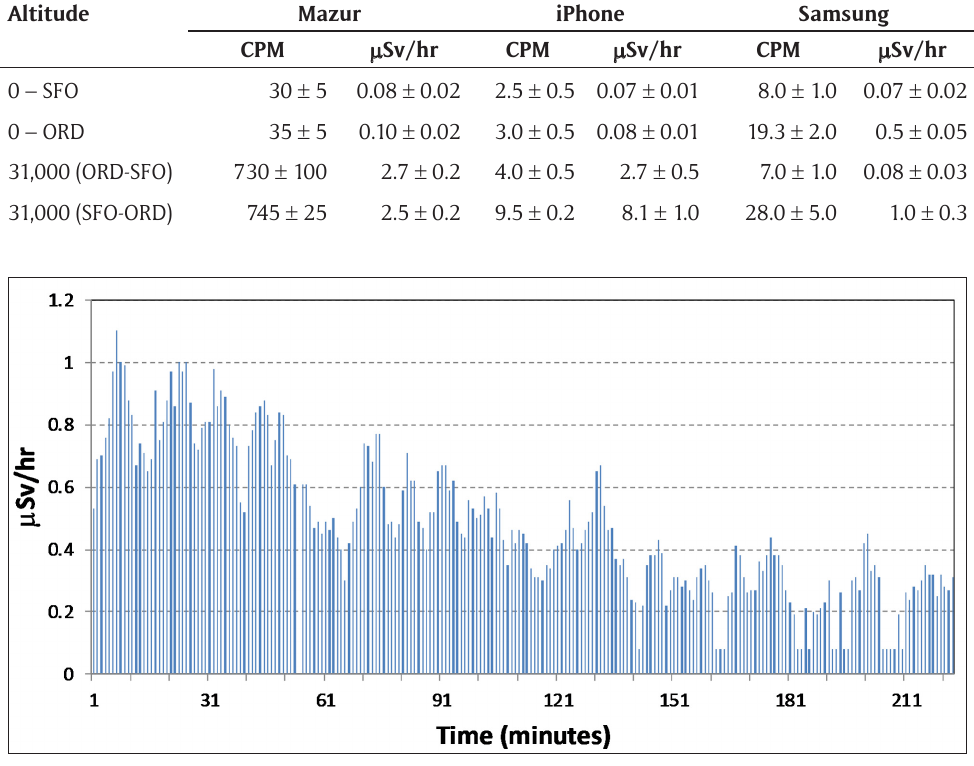
Figure 1: Radiation measurements with Samsung platform back camera for a temperature change from 29.9°C to